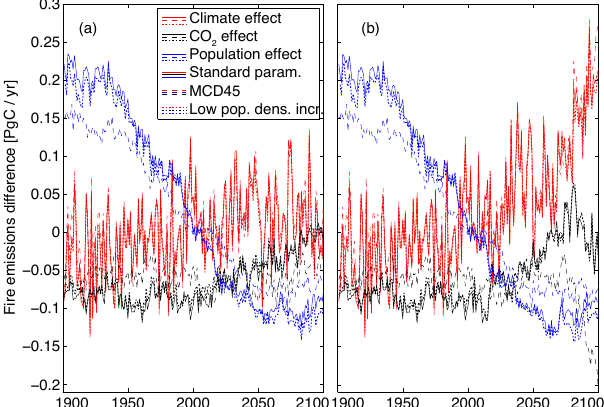
Figure 3. Impact of changing fire model parameterisation on the simulated climate, CO 2 and population effects on emissions. Standard parameterisation of SIMFIRE optimised against GFED3 burned area, optimisation against MCD45 burned area, and simula- tion assuming an increasing effect of population density on burned area between 0 and 0.1inhabitantskm − 2 . (a) RCP4.5. (b)